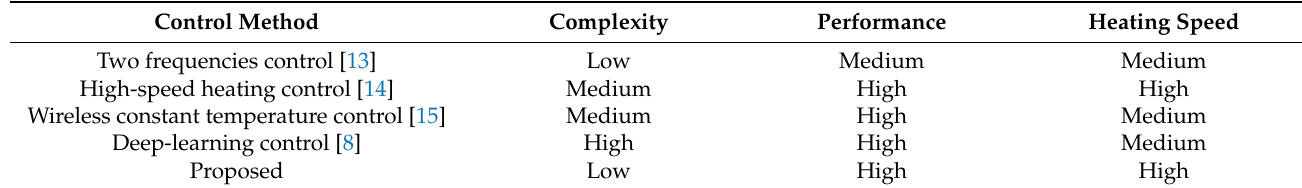
Table 2. Comparison among five induction heating control strategies.